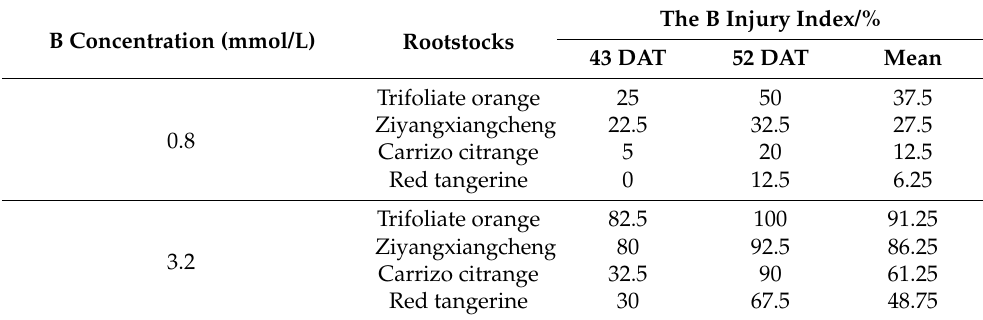
These results, thus, indicated that Trifoliate orange is the rootstock with the high- est level of B sensitivity, followed by Ziyangxiangcheng and Carrizo citrange, with Red tangerine exhibiting the highest levels of B